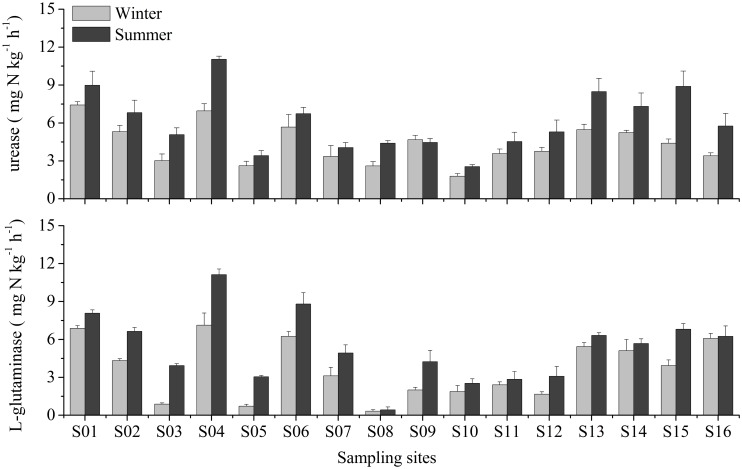
Activities of urease and L-glutaminase in surface sediments of the Yangtze Estuary.Vertical bars denote standard error of triplicate samples.